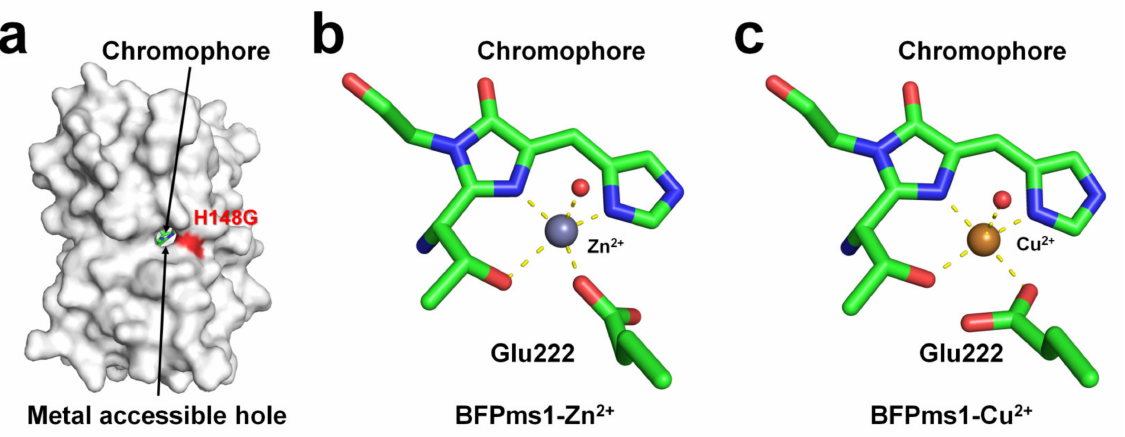
Figure 4. Crystal structure of native, Zn-bound (PDB code 1KYS), and Cu-bound (PDB code 1KYR) state of BFPms1. ( a ) Surface structure of BFPms1 showed an engineered hole, where the metal ion is accessible. ( b ) Zn 2+ and ( c ) Cu 2+ binding to the chromophore of